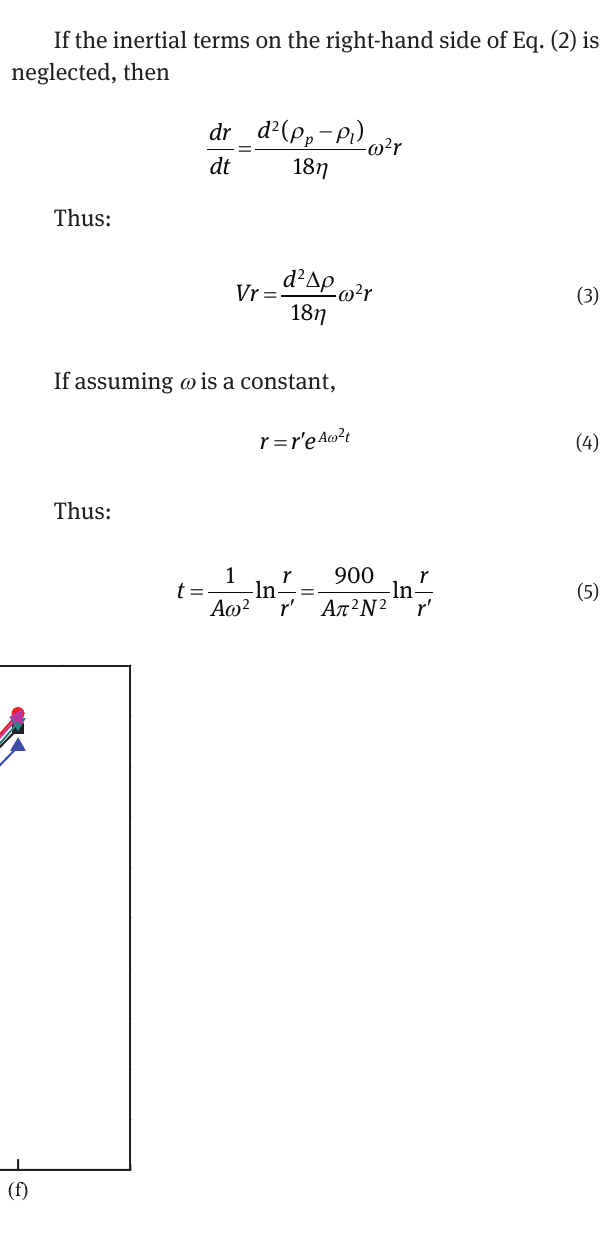
crystals increases with the area approaching to the bottom of the sample and the peak value appeared in area (f). When V-containing spinel particles are assumed to be spherical in shape and the fluid is laminar flow, the motion equation of V-containing spinel particles in the